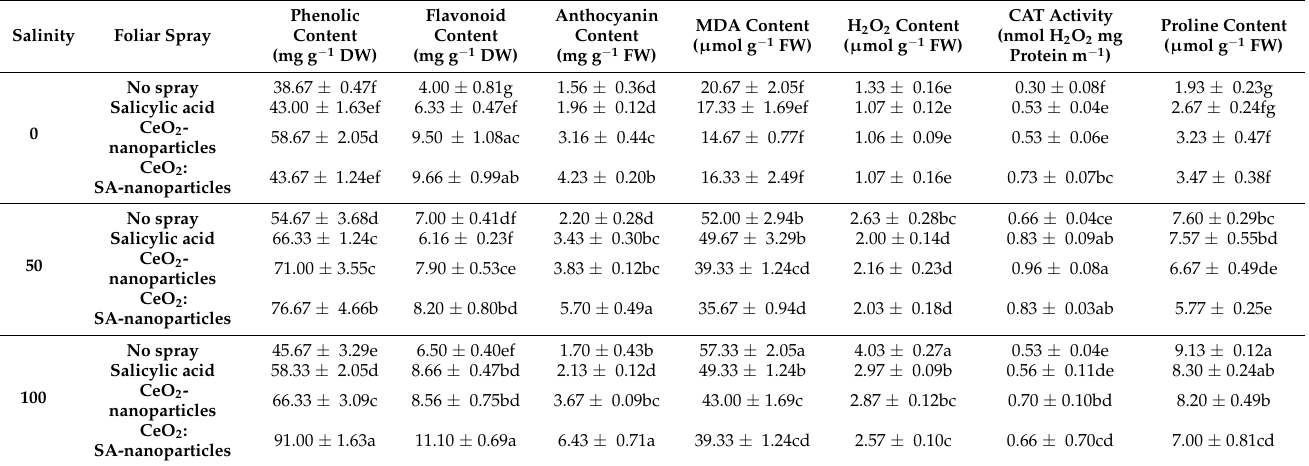
Table 6. Comparison of means for the effects of salinity (0–50 and 100 mM NaCl) and foliar applica- tions (no spray, salicylic acid, CeO 2 -nanoparticles, and CeO 2 :SA-nanoparticles) on some biochemical characteristics of Portulaca oleracea plants.